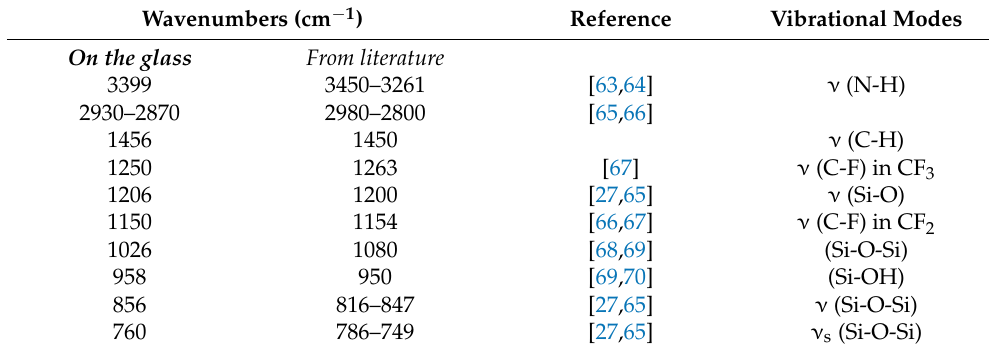
Figure 6. FT-IR spectra of glass slides treated with G_A, G_A F3, G_A F16, and G_A F3_F16 sol. Table 1. Main vibration modes ascribable to